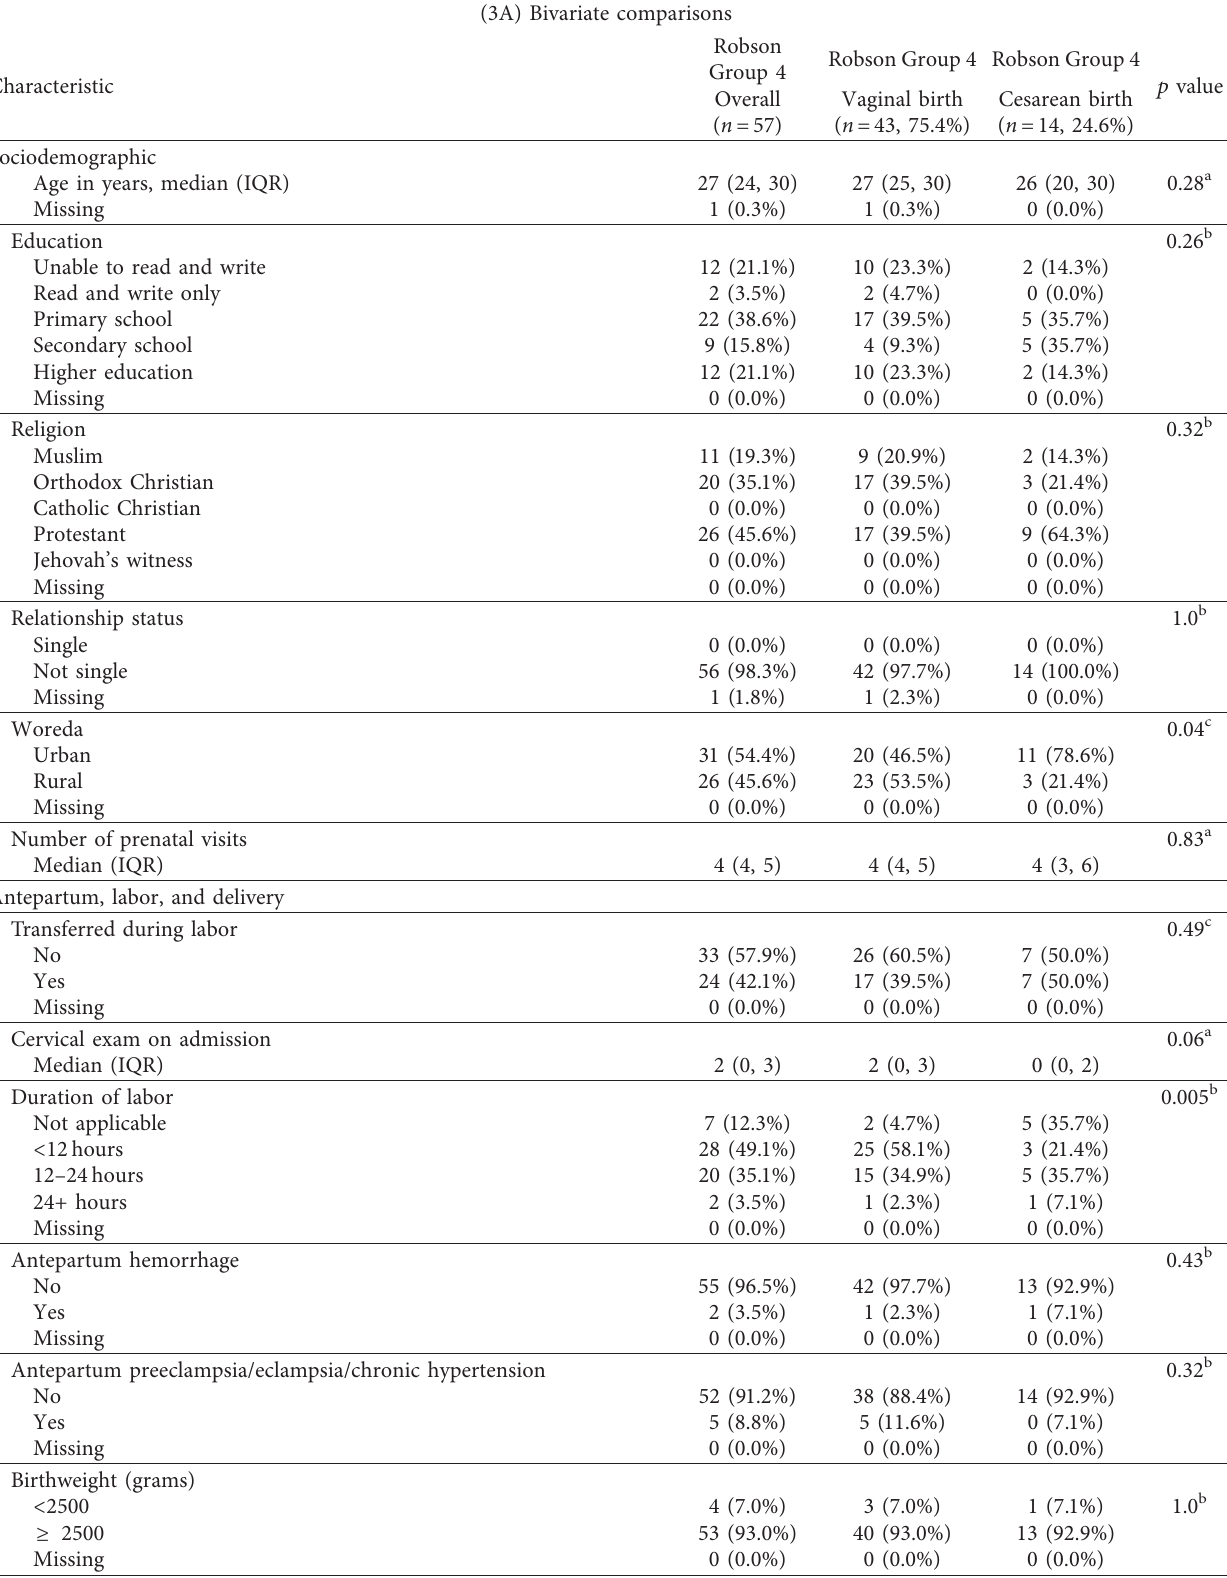
Table 3: Sociodemographic, obstetric, labor, and delivery characteristics of Robson Group 3 women who experienced cesarean birth compared to vaginal birth, bivariate comparisons, and multivariable